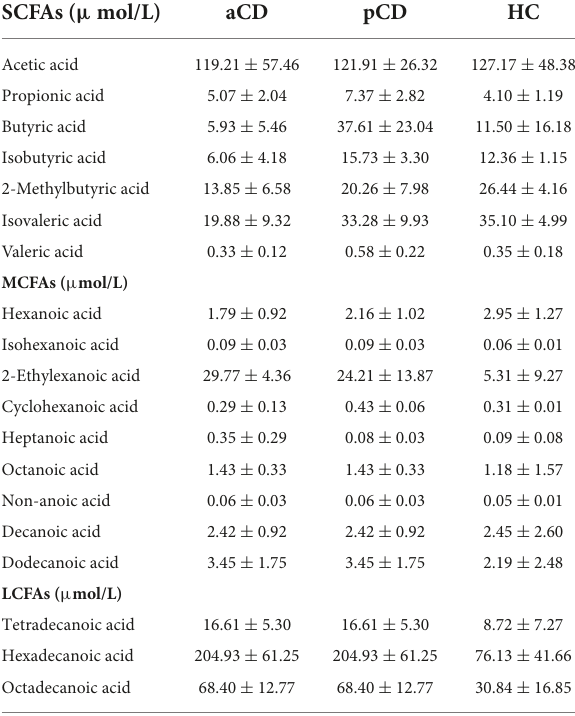
TABLE 3 SCFA, MCFA, and LCFA abundance in aCD and pCD patients and